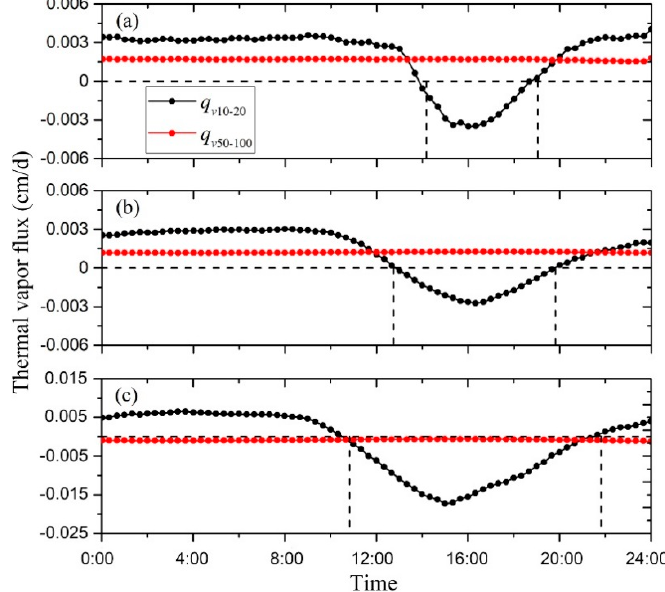
Figure 9. Diurnal variations of the thermal vapor flux at two layers (10–20 and 50–100 cm) on different days: ( a ) 16 November, ( b ) 1 February, and ( c ) 25 March. q v 10–20 and q v 50–100 are calculated vapor fluxes in soil layers 10–20 and 50–100 cm, respectively. Positive values indicate upward vapor flow, while negative values indicate downward vapor flow.